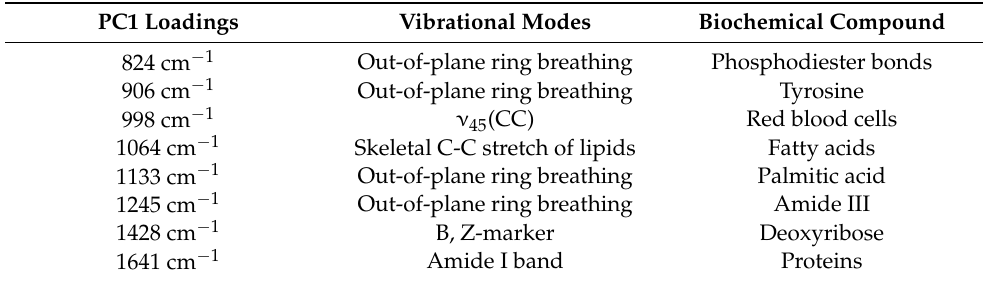
Figure 7. Wavenumber-dependent PC1 loadings (blue) and the zero line (red) for easier visualiza- tion of the absolute amplitude of loading values. Table 1. Vibrational modes assigned to peaks of absolute values of PC1 loadings [61].